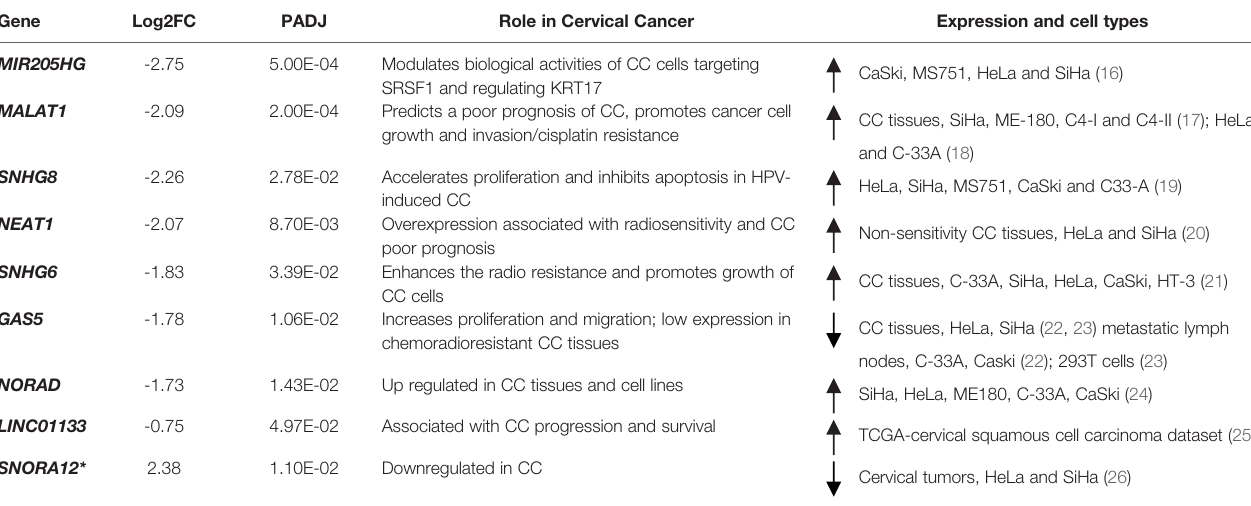
TABLE 1 | Long non-coding RNAs (lncRNA) and small RNA (snoRNA*) differentially expressed in cervical cancer stem-like cells from Non-responders (NR) and Responders (R) related to cancer pathogenesis. Gene